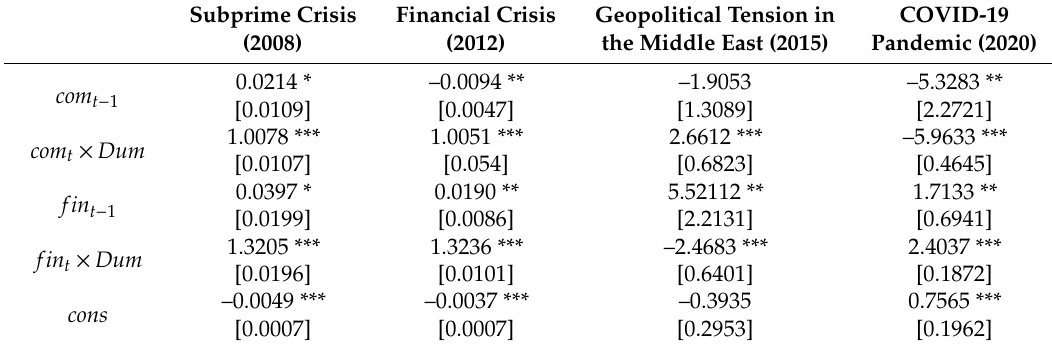
Table 5. Contests of two attributes of crude oil under the impacts of di ff erent